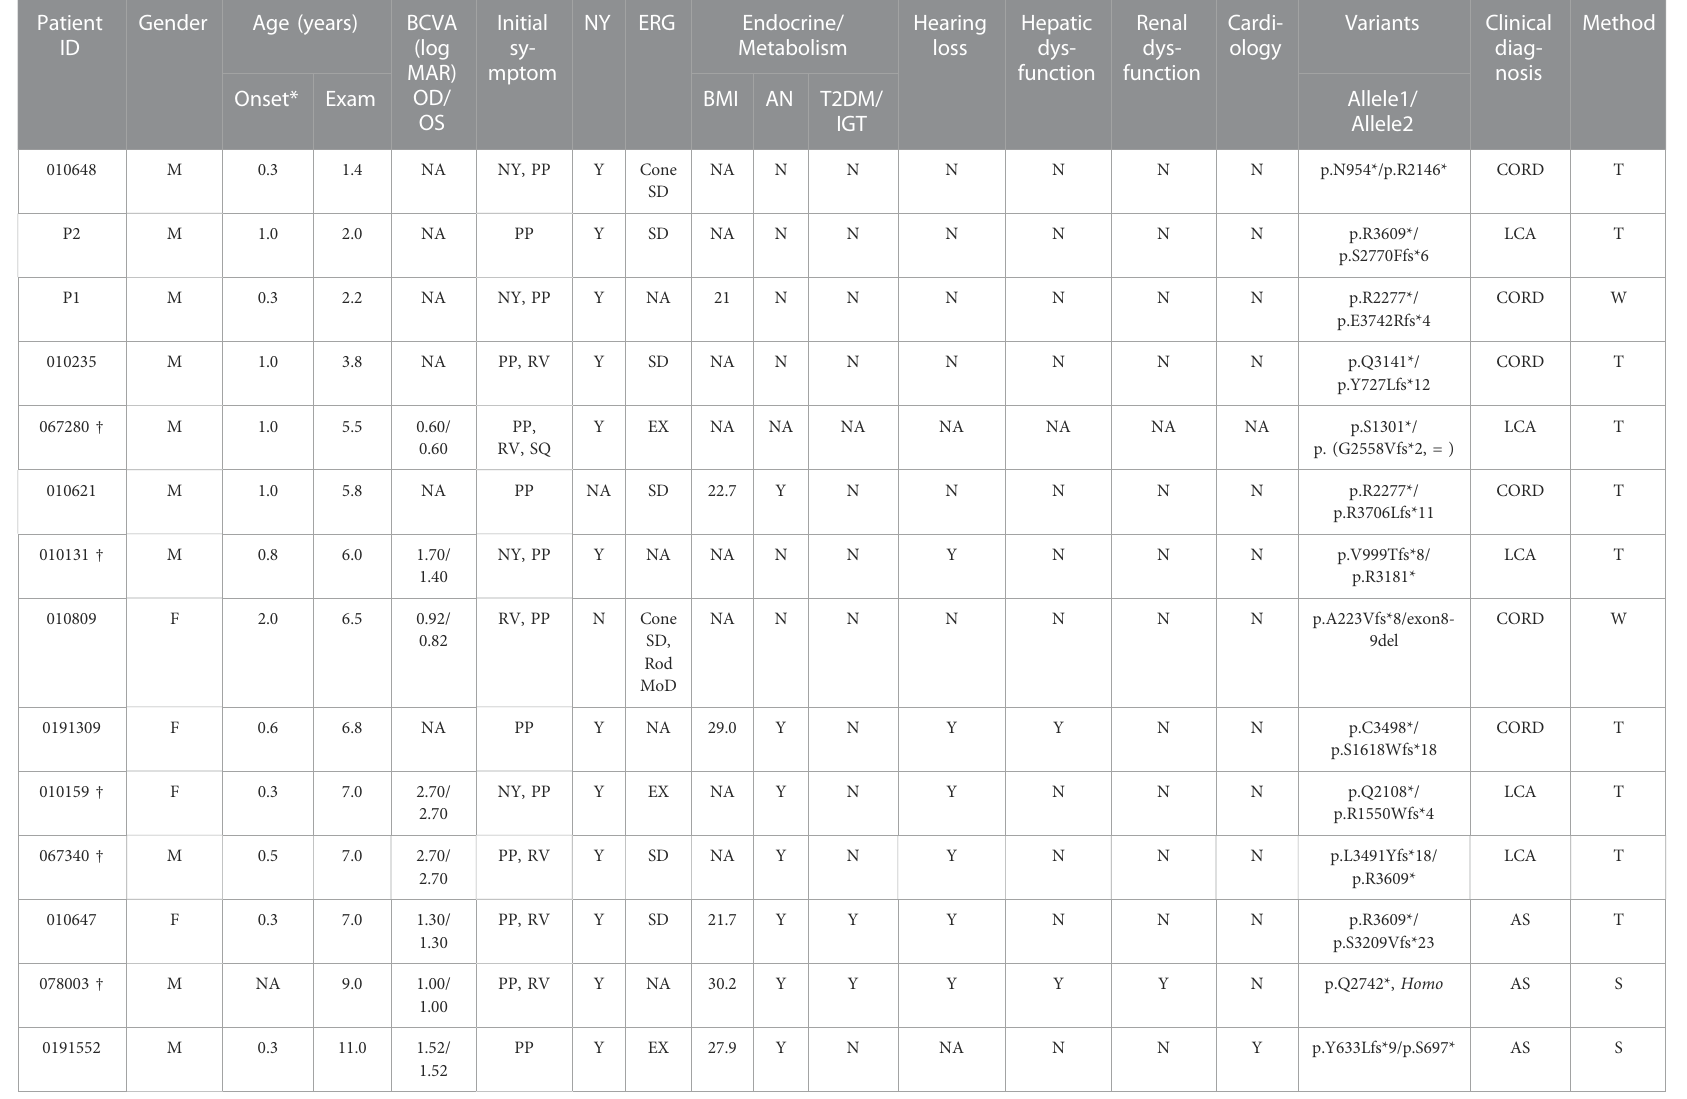
TABLE 2 The Clinical features and results of the ALMS1 gene variants screening of the